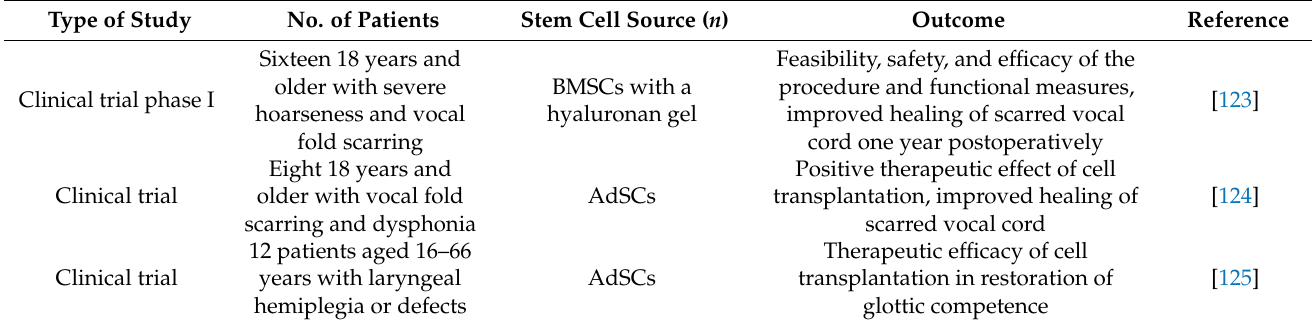
Table 4. Undertaken clinical trials in treatment of vocal fold scarring using